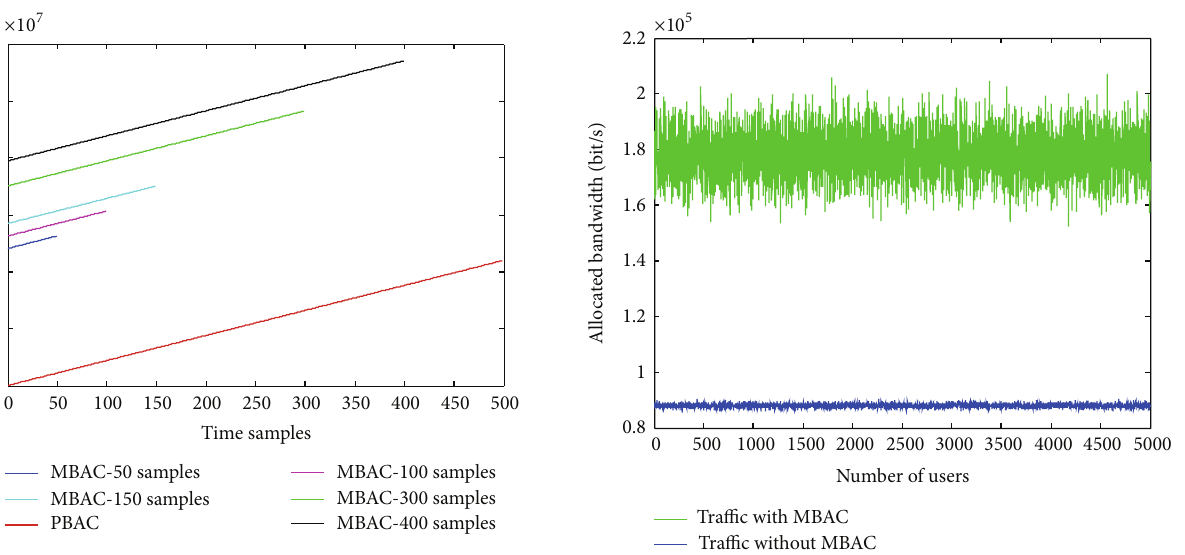
Figure 5: Comparison of traffic with applied MBAC method and without MBAC methods.